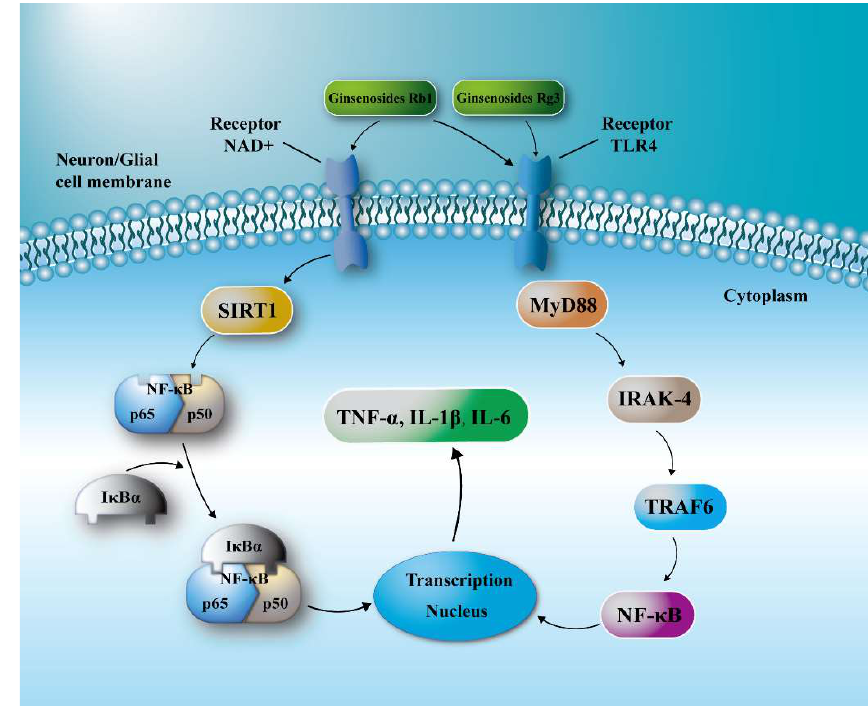
Figure 6. Schematic diagram for the neuroprotective effects of ginsenosides in I/R injury. Ginsenosides suppressed TLR4/MyD88 signaling and/or SIRT1 activation to reach a protective effect after I/R injury.